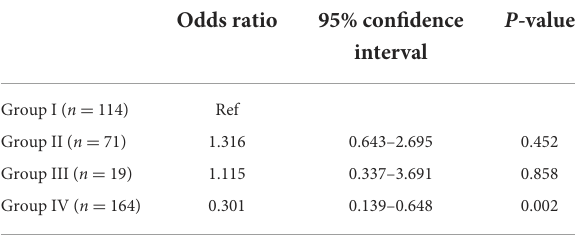
TABLE 3 Regression analysis based on platelet recovery to assess the association between platelet course and in-hospital mortality in critically ill children with early severe